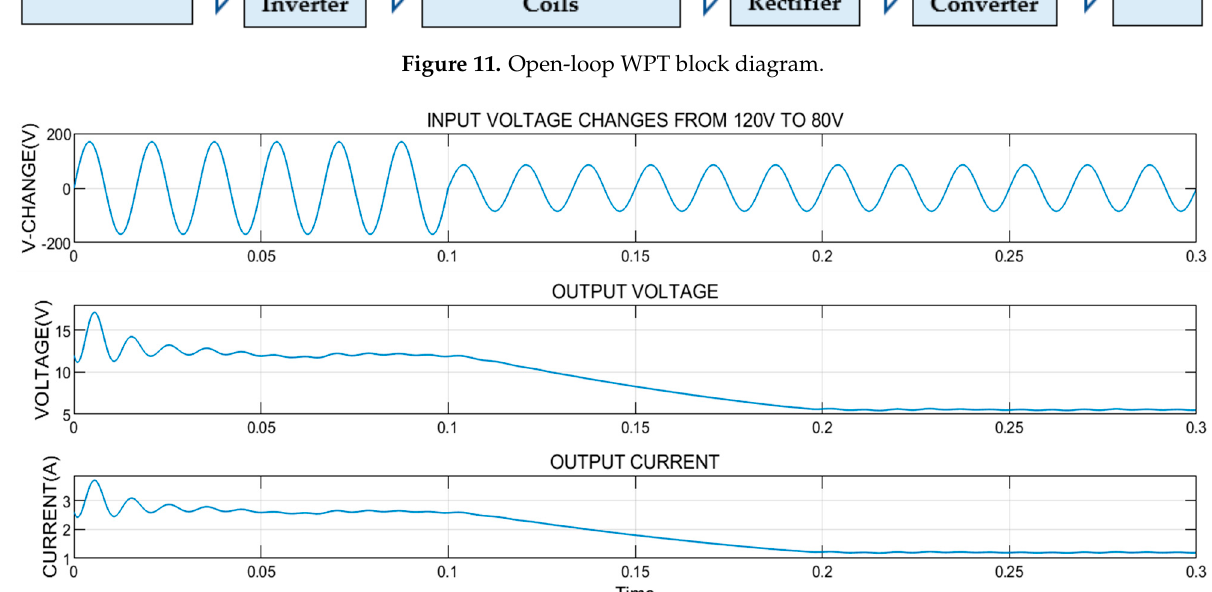
Figure 12. Open-loop simulation results for change in input.